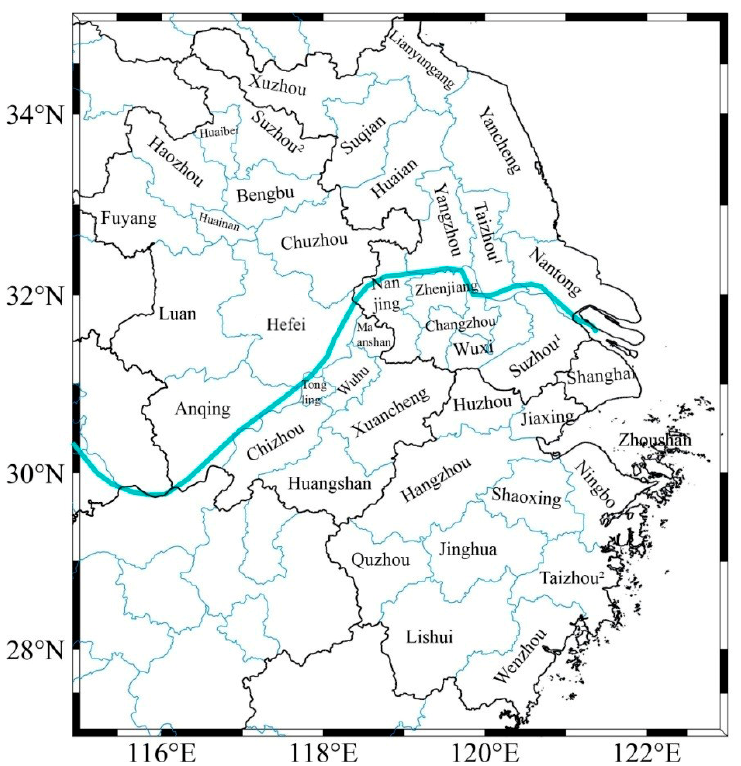
Figure 1. Administrative districts of 41 cities in the Yangtze River Delta (Suzhou 1 and Taizhou 1 are the cities in Jiangsu Province. Suzhou 2 and Taizhou 2 belong to Anhui and Zhejiang provinces, respectively). Note: the figure was made by the authors.